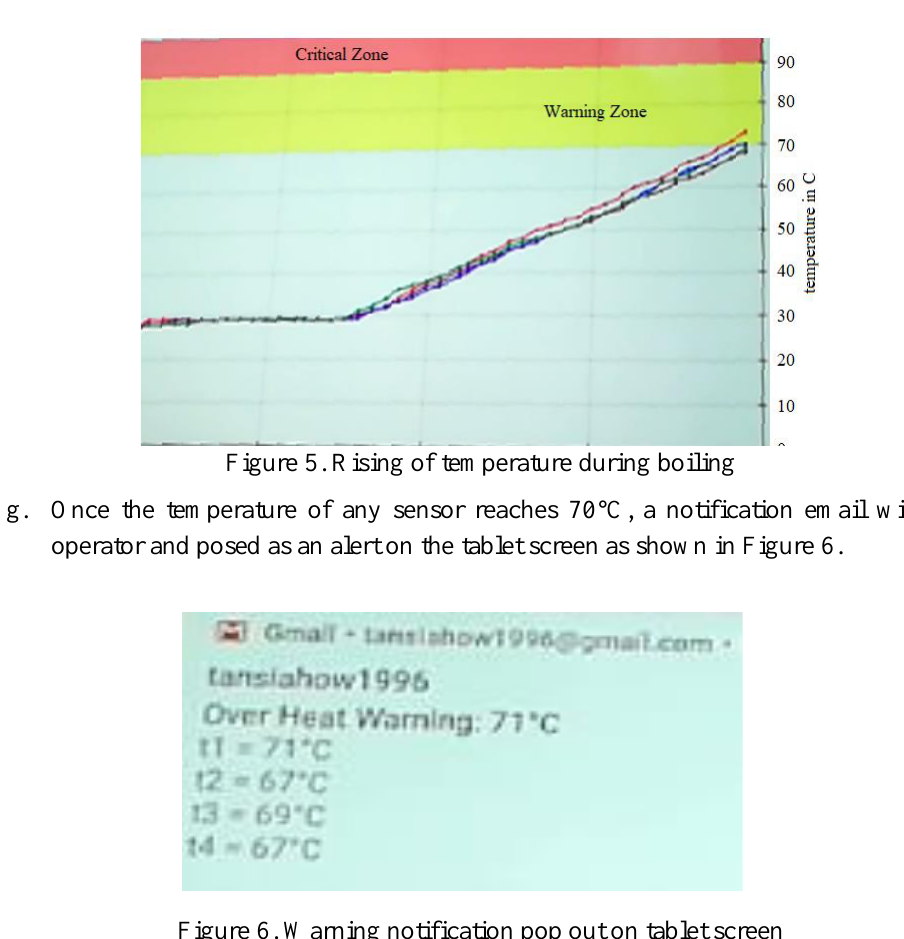
Figure 6. Warning notification pop out on tablet